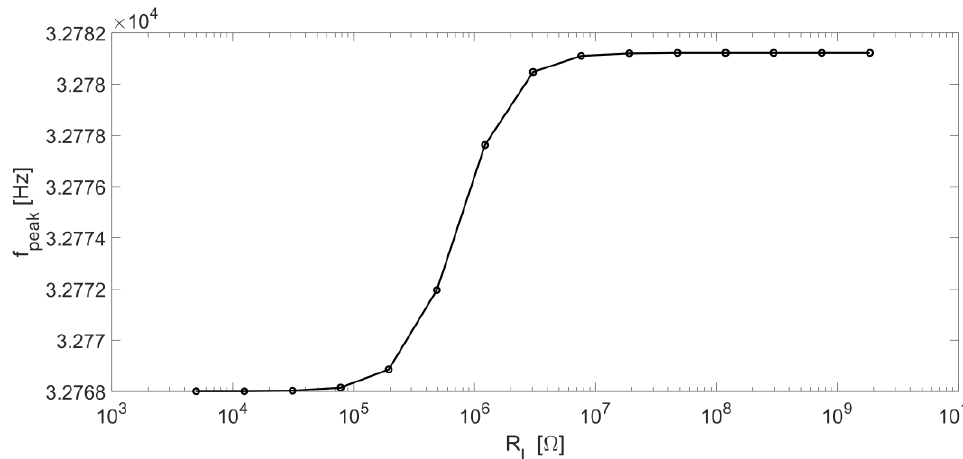
Figure 5. Peak frequency f peak of |H v | 2 as a function of R L . For R L values lower than 100 k Ω , f peak tends to the series-resonant frequency f S = 32768 Hz; whereas, for values of R L higher than 2 M Ω , f peak tends to assume the values of the parallel-resonant frequency f P , in our case equal to 32781 Hz.